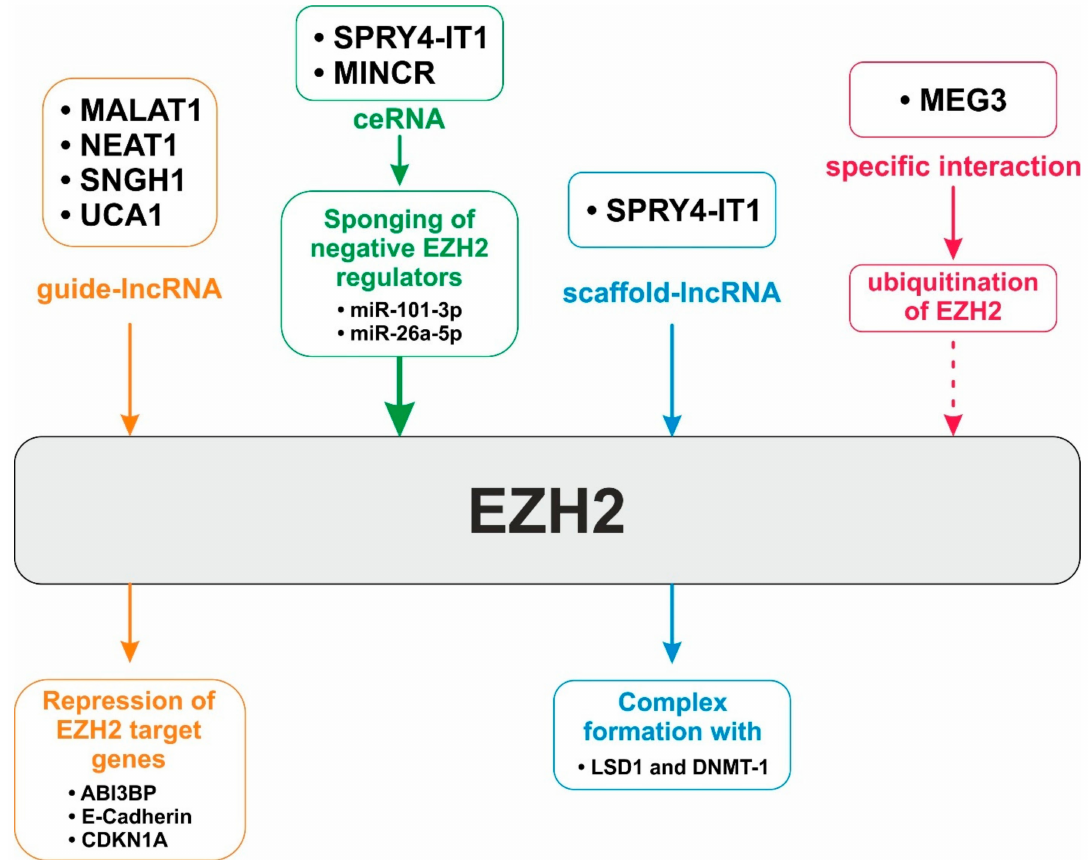
Figure 3. Overview of the versatility of lncRNA-based regulation of EZH2 in biliary tract cancer. Guide-lncRNAs directly interact with EZH2 and guide EZH2 (as enzymatic part of the polycomb repressive complex 2) to specific target gene promoters for epigenetic gene silencing. Via sponging negative EZH2 regulators (miR-101-3p and miR-26a-5p), ceRNAs positively regulate EZH2 protein levels. SPRY4-IT1 serves as a sca ff old lncRNA to allow the assembly and thereby the functionality of an epigenetic regulatory complex consisting of EZH2, LSD1 and DNMT1. MEG3 negatively regulates EZH2 protein expression via initiation of EZH2 ubiquitination and, consequently, EZH2 degradation. Abbreviations: lncRNA: long-noncoding RNA; miR: